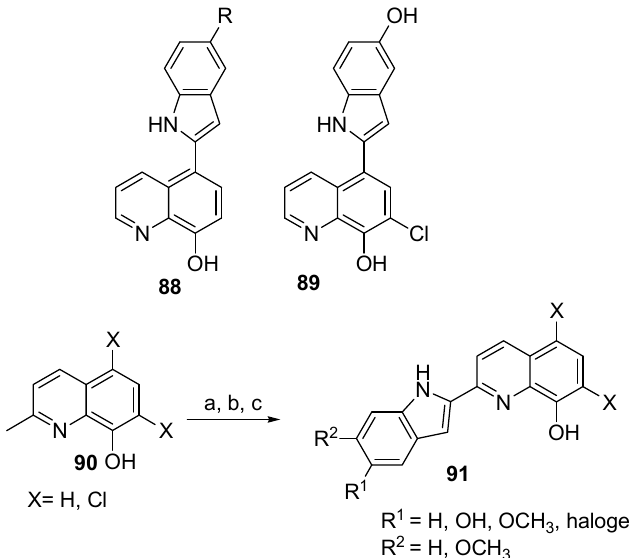
Figure 6. Chemical structures of some indole-based 8-hydroxyquinoline derivatives. Reagents: ( a ) acetic anhydride, 2-nitrobenzaldehydes; ( b ) 1,10-phenathroline·H 2 O, Pd(OAc) 2 , CO; ( c ) K 2 CO 3 or NaOCH 3.